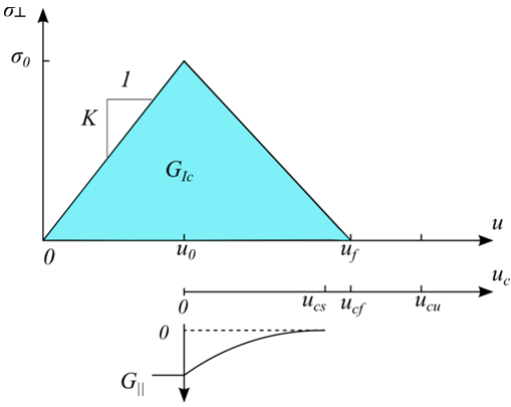
Fig. 5 Hillerborg model: tensile stress for Mode I cracking in function of relative nodal displacement and crack opening displacement; Shear stiffness reduction in function of crack opening